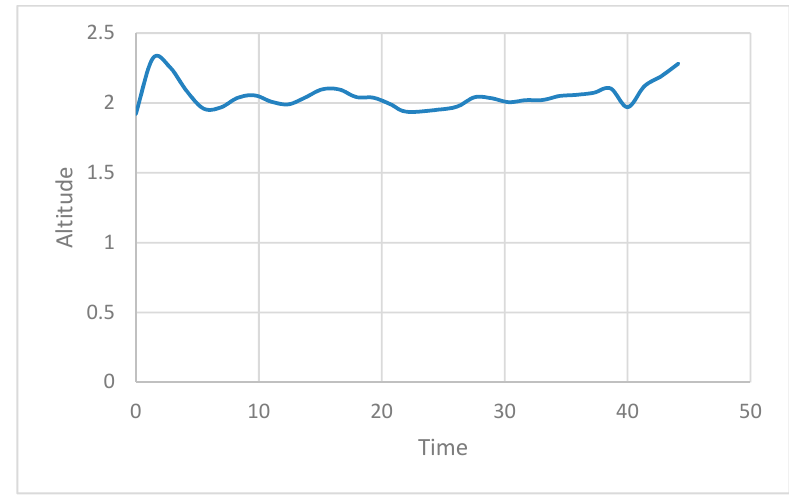
Figure 15. UAV flight altitude with security framework in native ROS.